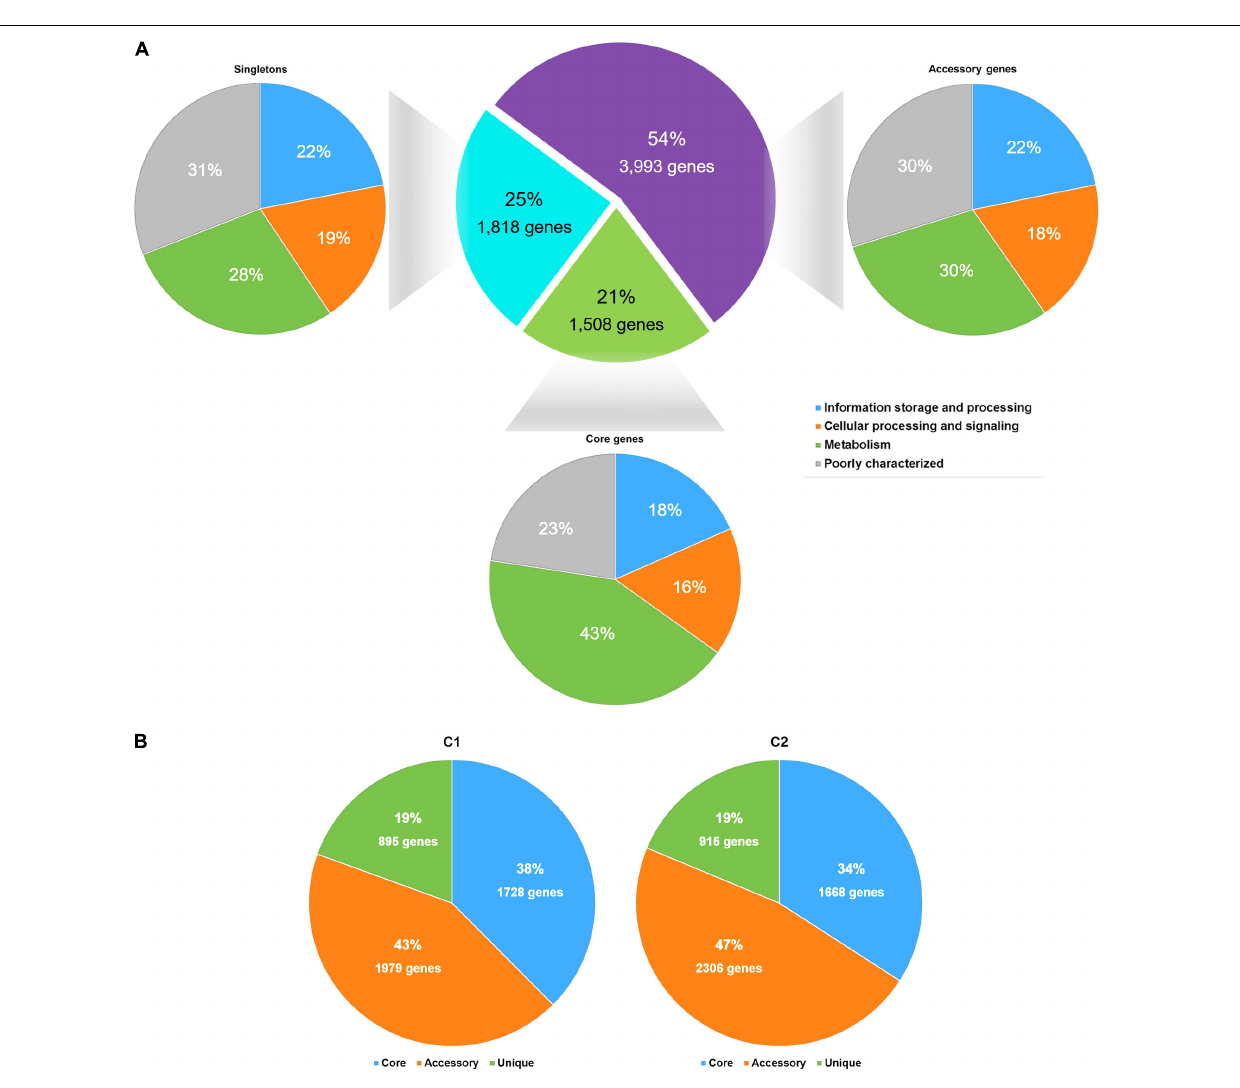
FIGURE 2 | The statistics of the S . argenteus pangenome. (A) The S . argenteus pangenome was subdivided into three categories: (i) the core genome (the set of genes shared by all genomes), (ii) the accessory genome (the set of genes present in some but not all genomes), and (iii) the unique genome (genes that are unique to a single genome). The COG functional classification of each gene in a group is presented. (B) Proportions of the core genome, accessory genome, and unique genome in S . argenteus clusters C1 and